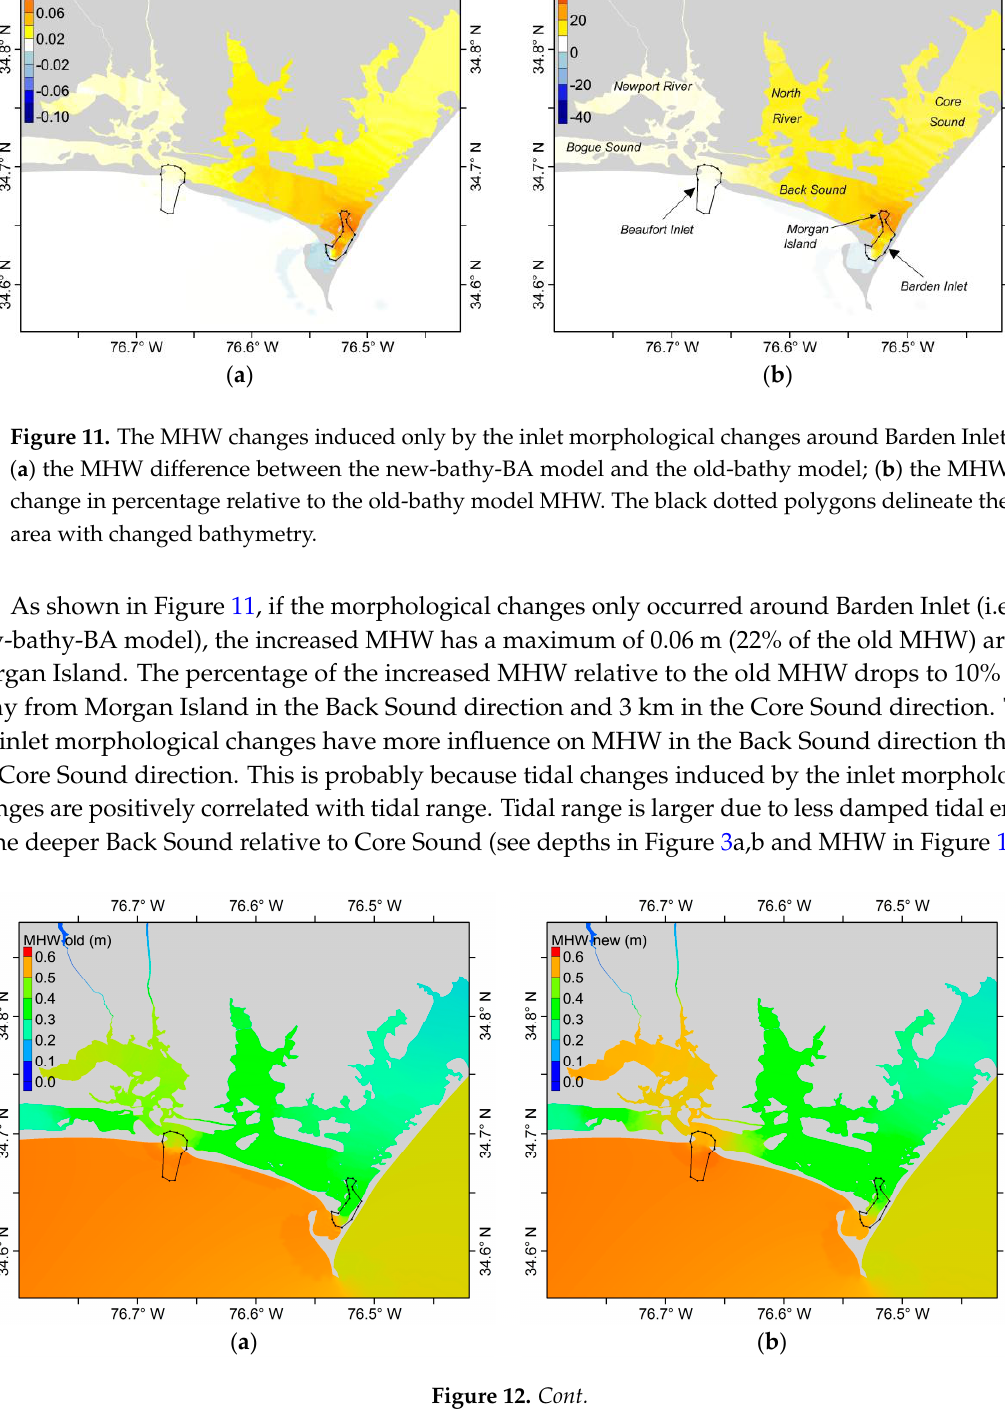
Figure 10. The MHW changes induced only by the inlet morphological changes around Beaufort Inlet: ( a ) the MHW difference between the new-bathy-BE model and the old-bathy model; ( b ) the MHW change in percentage relative to the old-bathy model MHW. The black dotted polygons delineate the area with changed bathymetry.